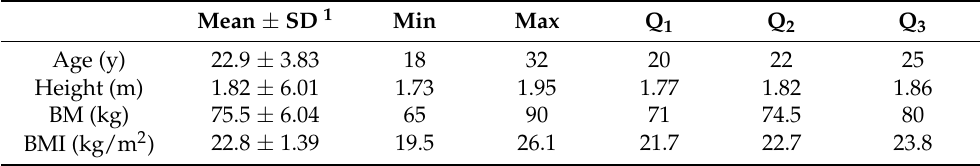
Table 1. Subject characteristics ( n =